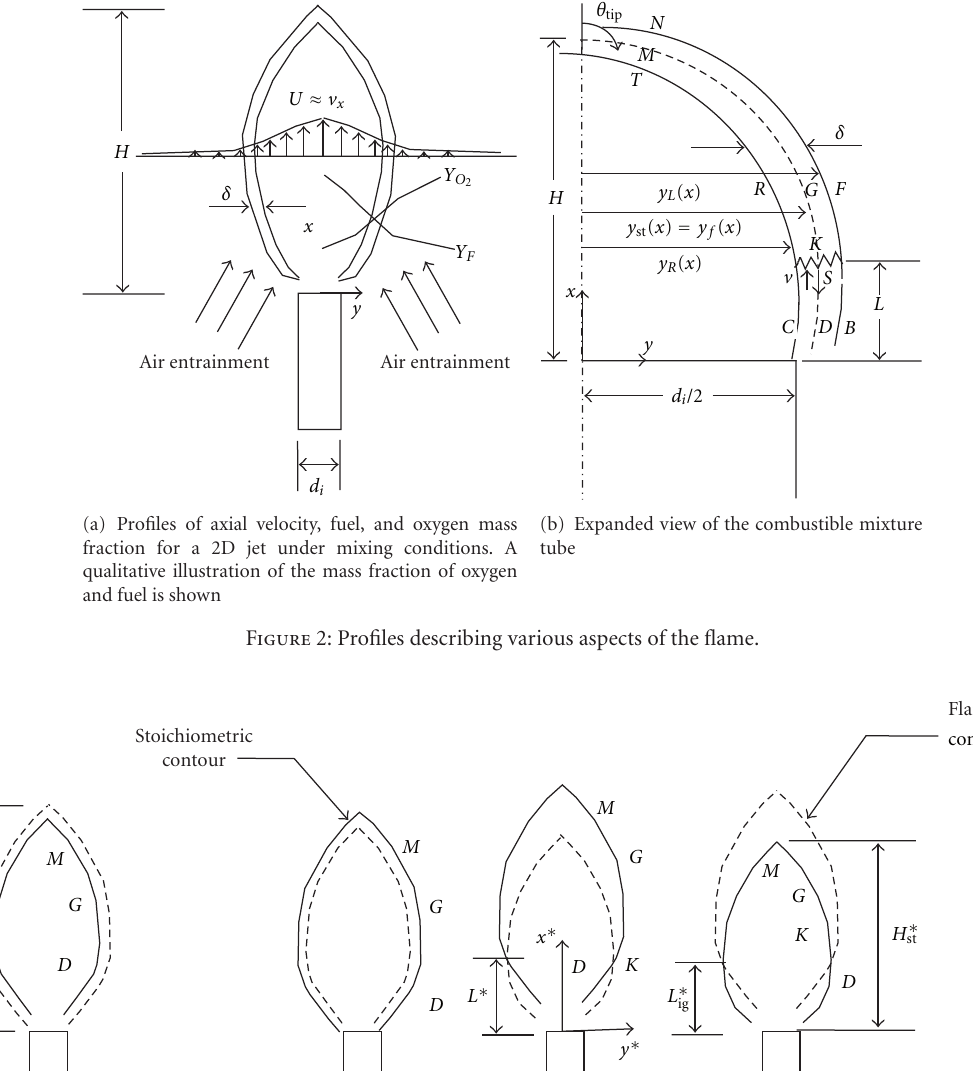
Figure 3: Qualitative illustrations of stoichiometric (solid) and flame speed (dashed) contours; H ∗ (nondimensional height).